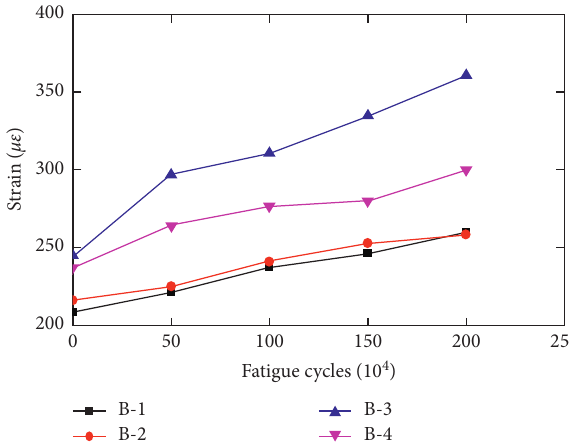
Figure 21: The relation between deflection and fatigue cycle times for different test beams.